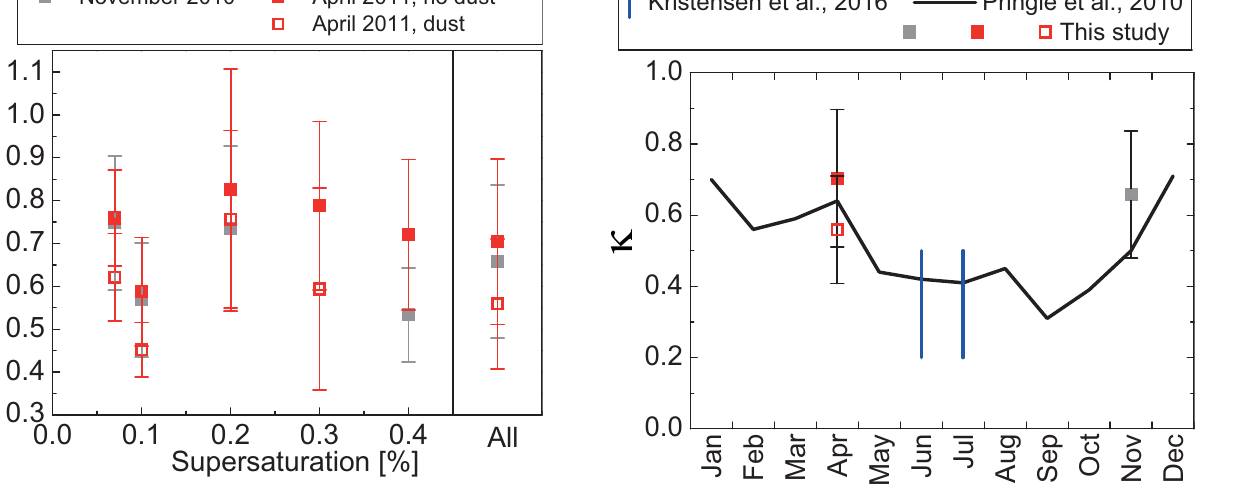
Figure 3. κ values reported in the literature based on modeling (Pringle et al., 2010) and measurements (Kristensen et al., 2016; data taken during SALTRACE in 2013) and those derived in this study for November 2010 and April 2011 (color code for the latter is the same as that used in Fig.